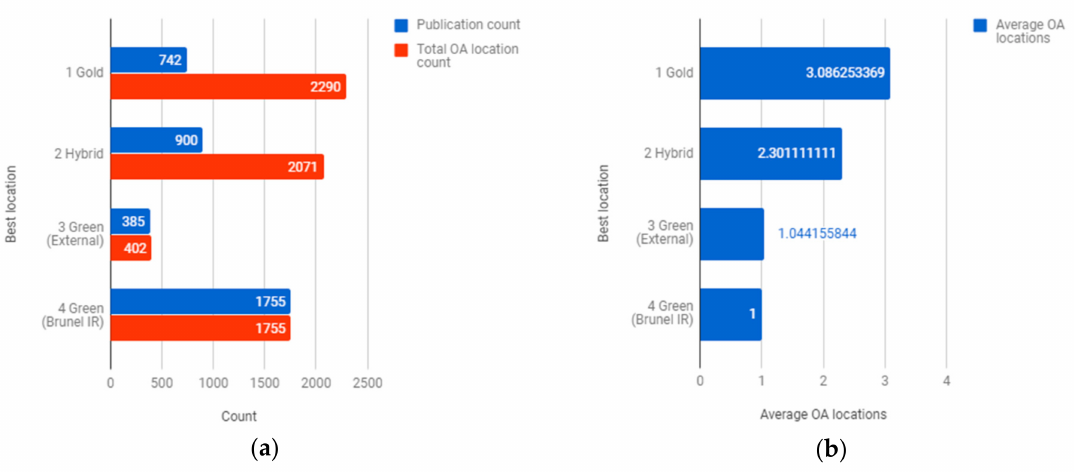
Figure 7. The total OA locations (‘Best available’ classification) 2014–2017, ( a ) total OA locations; ( b ) average OA